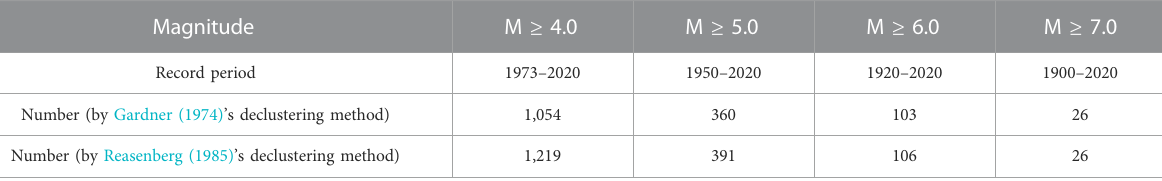
TABLE 1 Time periods of complete earthquake records in Taiwan area.